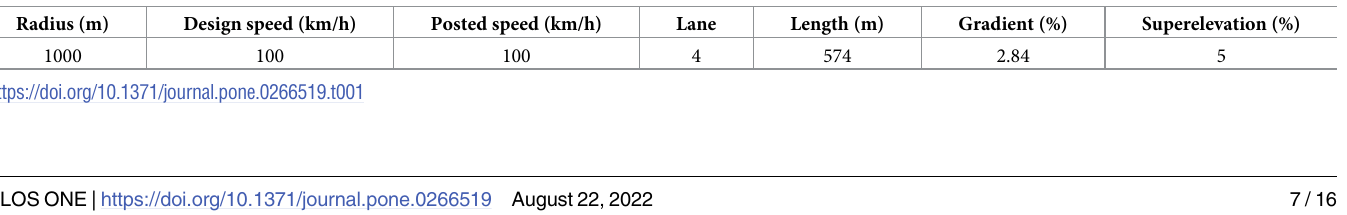
Fig 4. The Kolmogorov-Smirnov test results of the speed data are shown in Table 2. The two- Table 1. Geometric